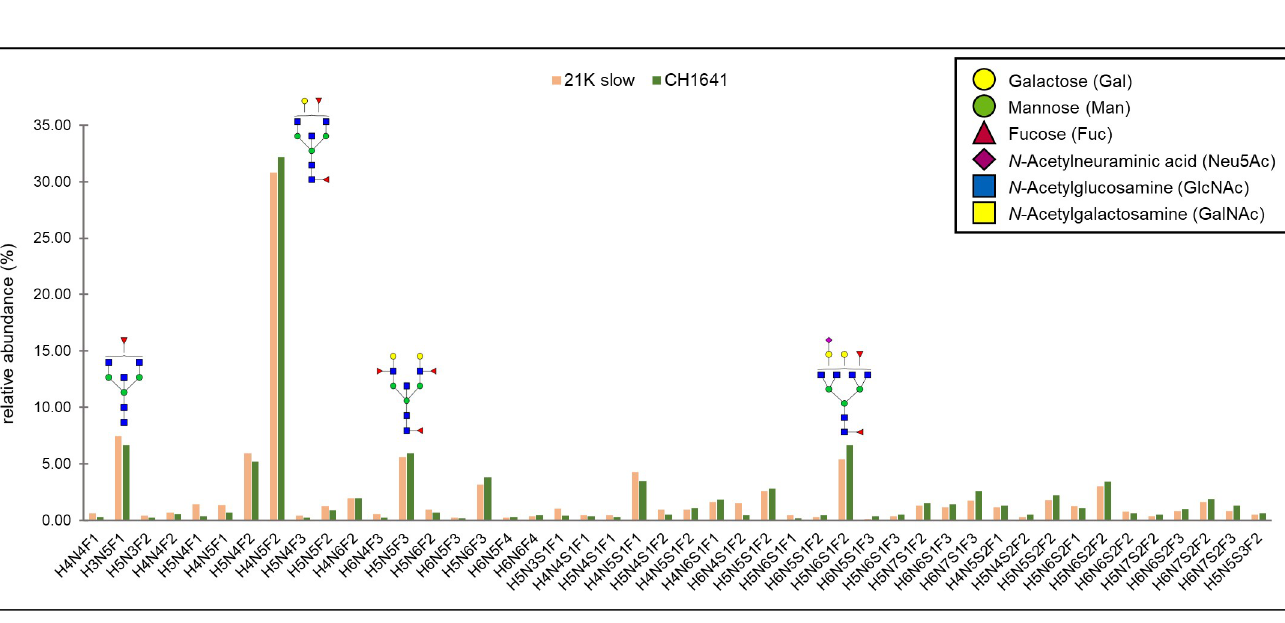
PLOS Pathogens| https://doi.org/10.1371/journal.ppat.1009232 February 18,